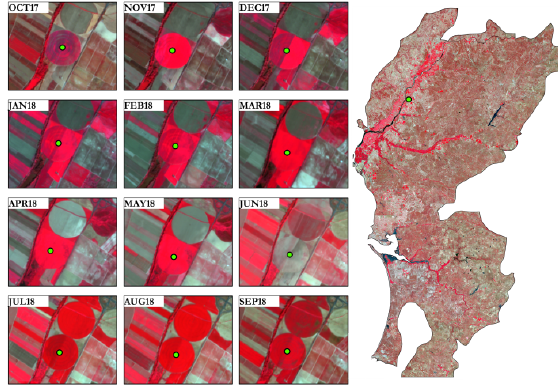
Figure 5. Series of monthly composites (1 year); the pointed area corresponds to an agricultural area